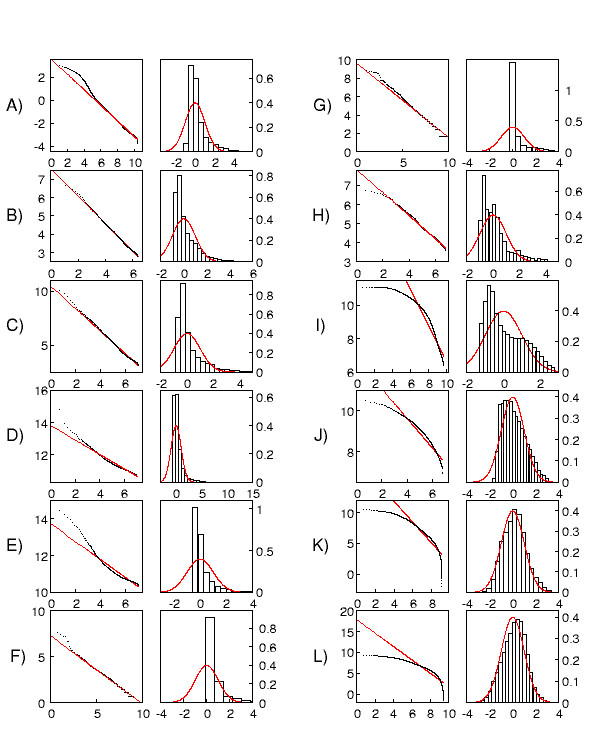
Data set comparison. Eleven microarray data sets (A-K) exhibiting varying degrees of conformation to power law and log normal distributions. On the left for each data set is a log mean intensity vs. log rank plot of the entire data set. Each array was sorted independently by intensity, and mean intensities for each rank over all arrays are plotted. A linear regression line is shown in red. Data sets with a linear distribution adhere well to a power law distribution. On the right for each data set is the distribution (ln(i) – μ) / σ of the mean intensities used in the left hand plots, where i is the mean measured intensity for each rank and μ and σ are the mean and variance of i respectively. The standard normal curve N(0,1) is shown in red for comparison. Data sets that display a standard normal distribution adhere well to a log normal distribution.